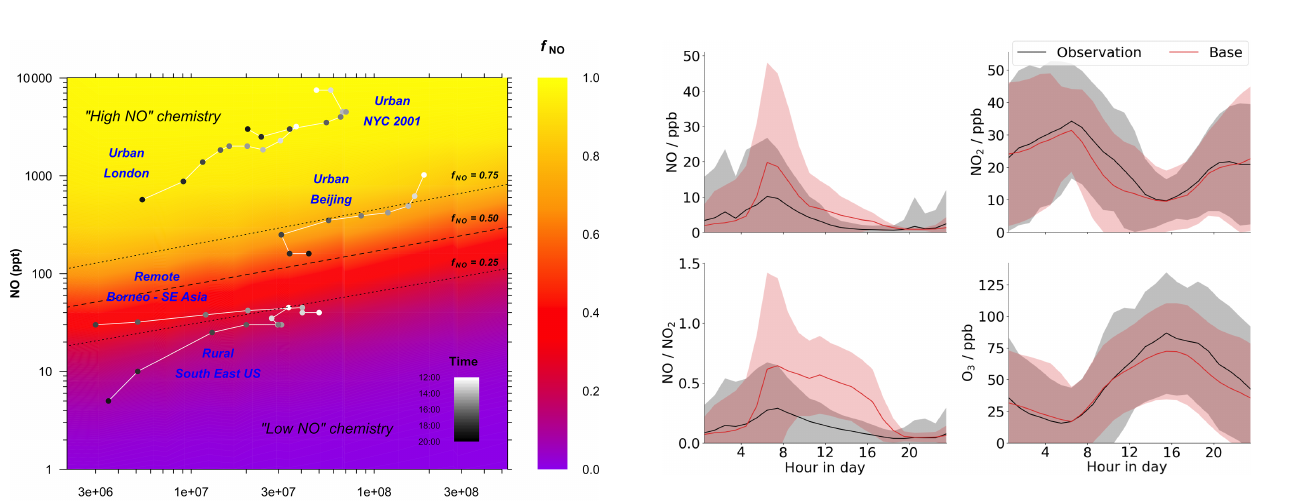
Figure 4. Comparison of GEOS-Chem model output (red) to mean diurnal measurements for the entire campaign (black) for NO, NO 2 , O 3 , and the NO / NO 2 ratio. Shaded regions are 2 standard devia- tions of the